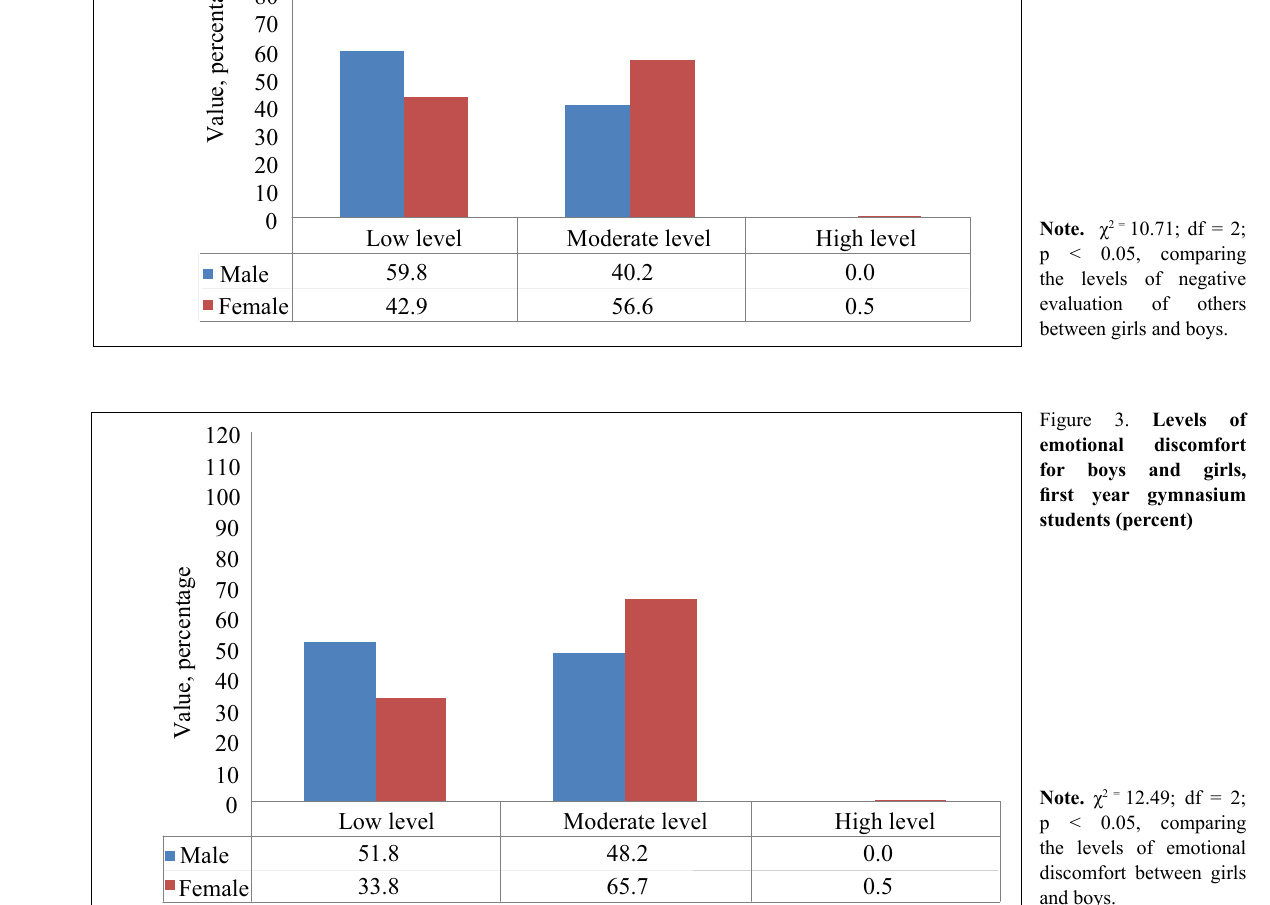
Figure 2. Levels of negative evaluation of others for boys and girls, first year gymnasium students (percent)